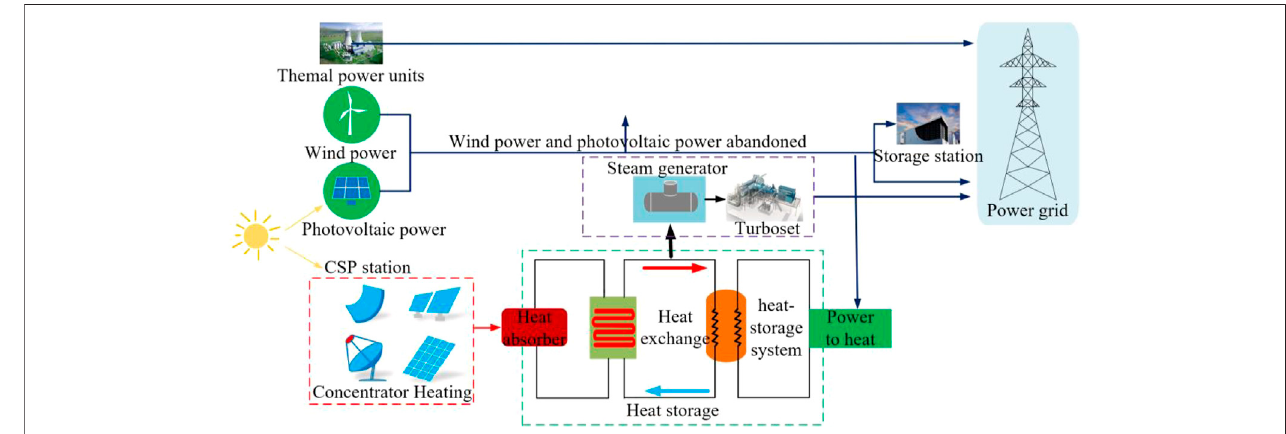
FIGURE 1 | Regional renewable energy grid framework with the ESS and CSP plant.